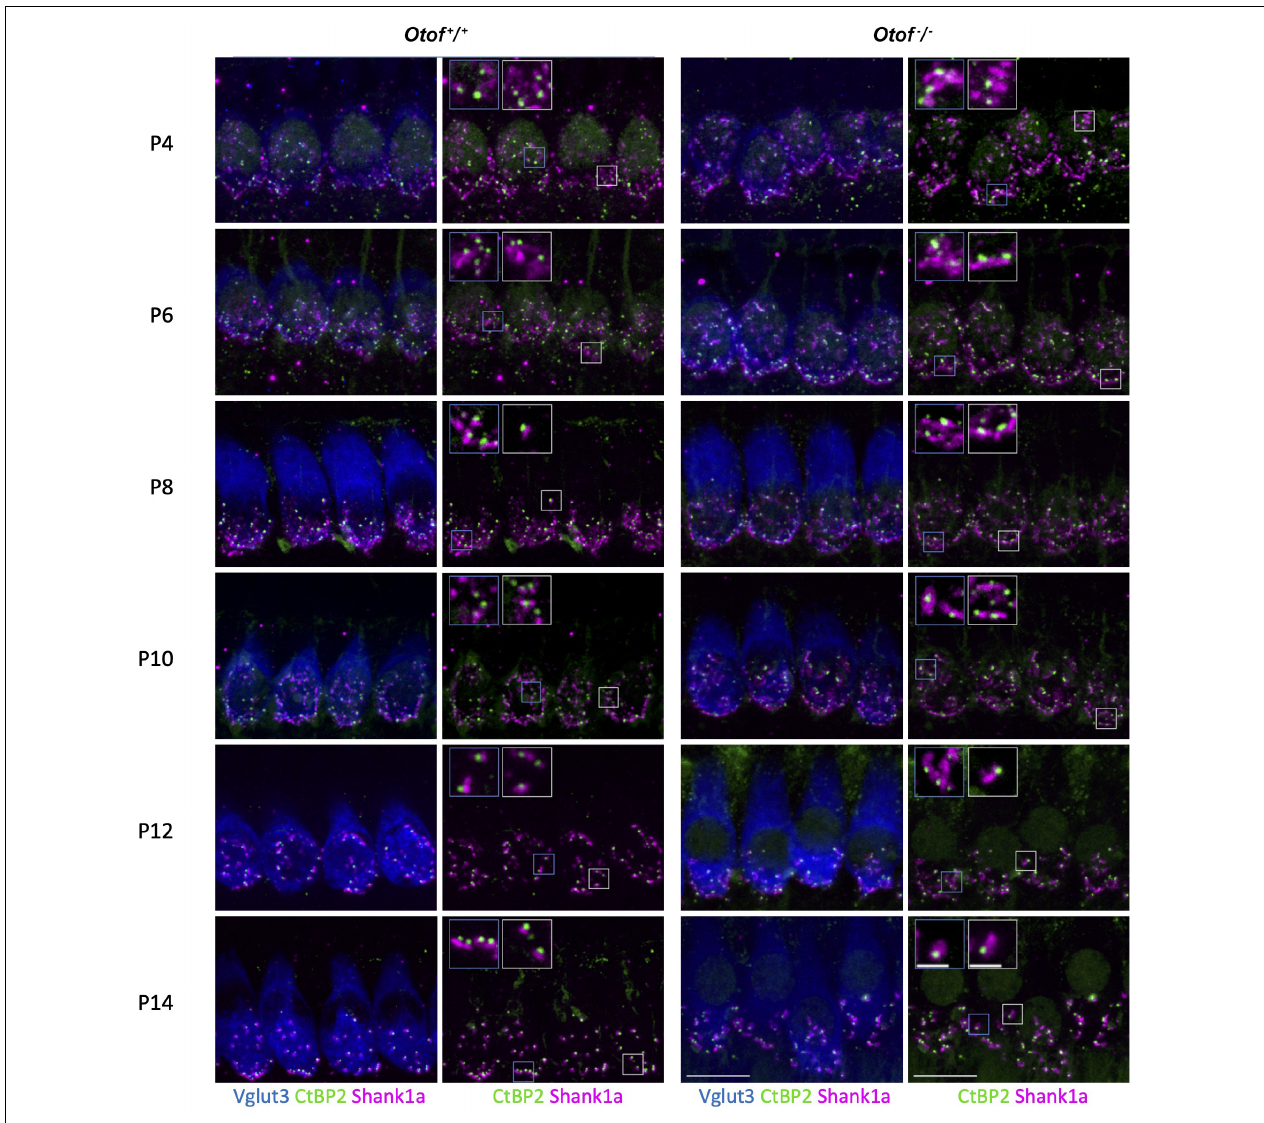
FIGURE 2 | Immunohistochemistry of IHC synapses in the first two postnatal weeks. Two left columns: Otof + / + controls, two right columns, Otof − / − IHCs. In column 1 and 3, IHCs are visualized by Vglut3 immunostaining. Afferent synapses of Otof + / + and Otof − / − IHCs were immunolabelled for Ctbp2, which is identical to the B-domain of the ribbon component ribeye. Antibodies against Shank1a labeled postsynaptic boutons. Insets show higher-magnification views of representative synapses. Note that postsynapses of Otof + / + controls become smaller during maturation, but not in Otof − / − IHCs. Maximum projections of high-resolution confocal micrographs, scale bar 10 µ m; scale bar of insets: 2 µ m. P6 and P14 data are partially replotted from Al-Moyed et al.